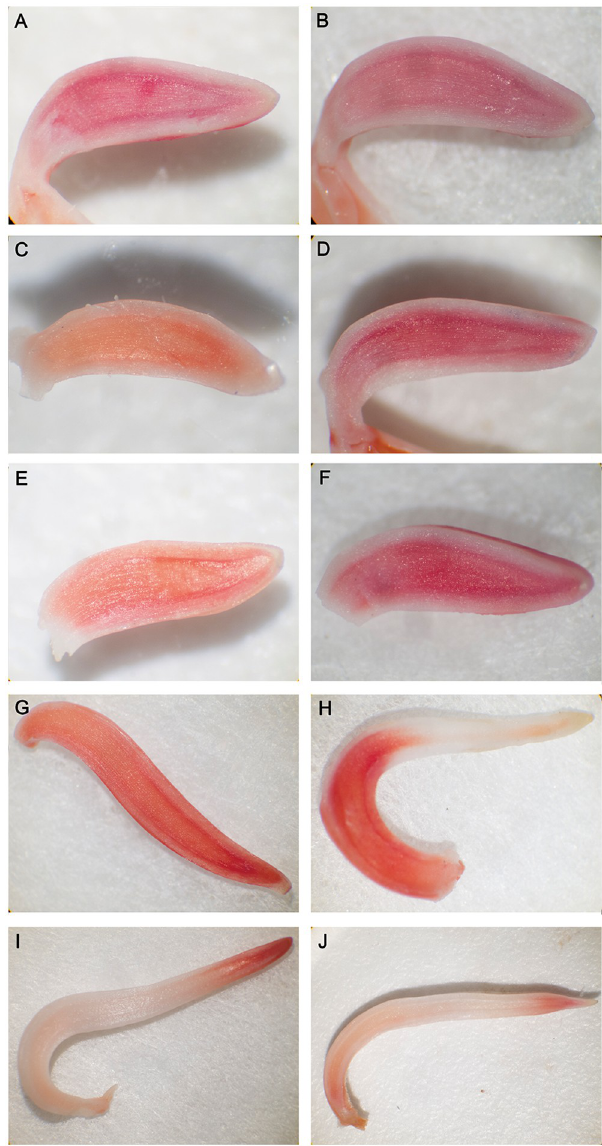
Fig 2. TTC staining of mung bean hypocotyls in different preimbibition and dehydration states. A, C, E, G and I represent the longitudinal section of the hypocotyl with 0, 3, 6, 18 and 24 h of preimbibition, respectively. B, D, F, H and J represent the longitudinal section of the hypocotyl with 0, 3, 6, 18 and 24 h of preimbibition after 24 h of dehydration, respectively.